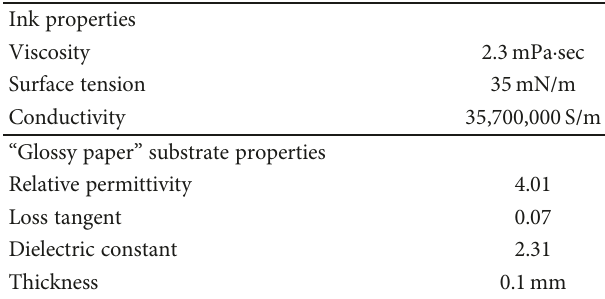
Figure 4: Radiation pattern of the ULA with 16 subarrays. Table 1: Properties of ink and substrate used for